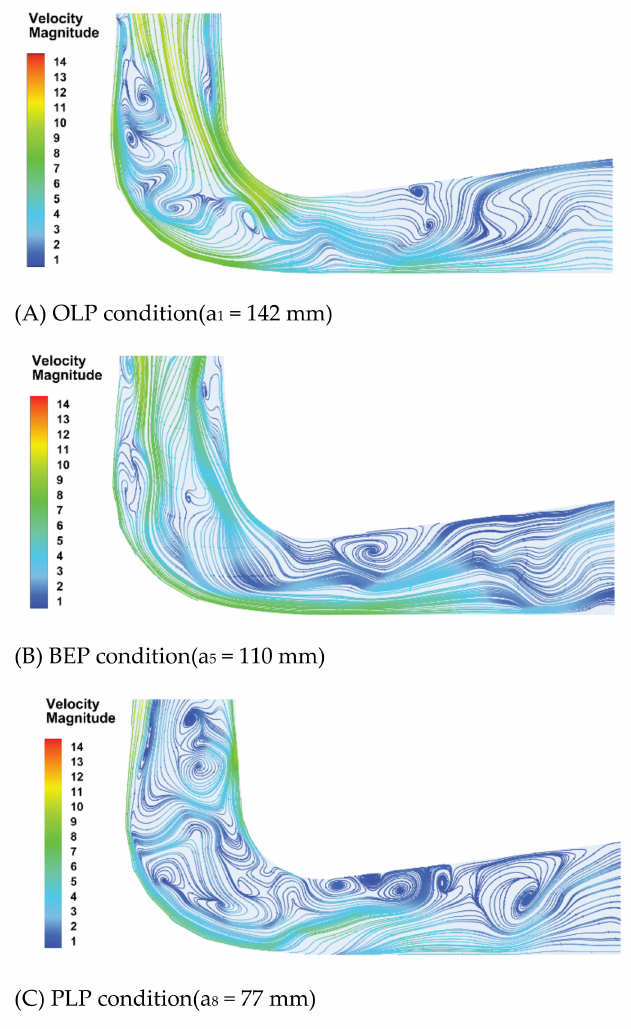
Figure 15. Streamline of central section of draft tube under different working